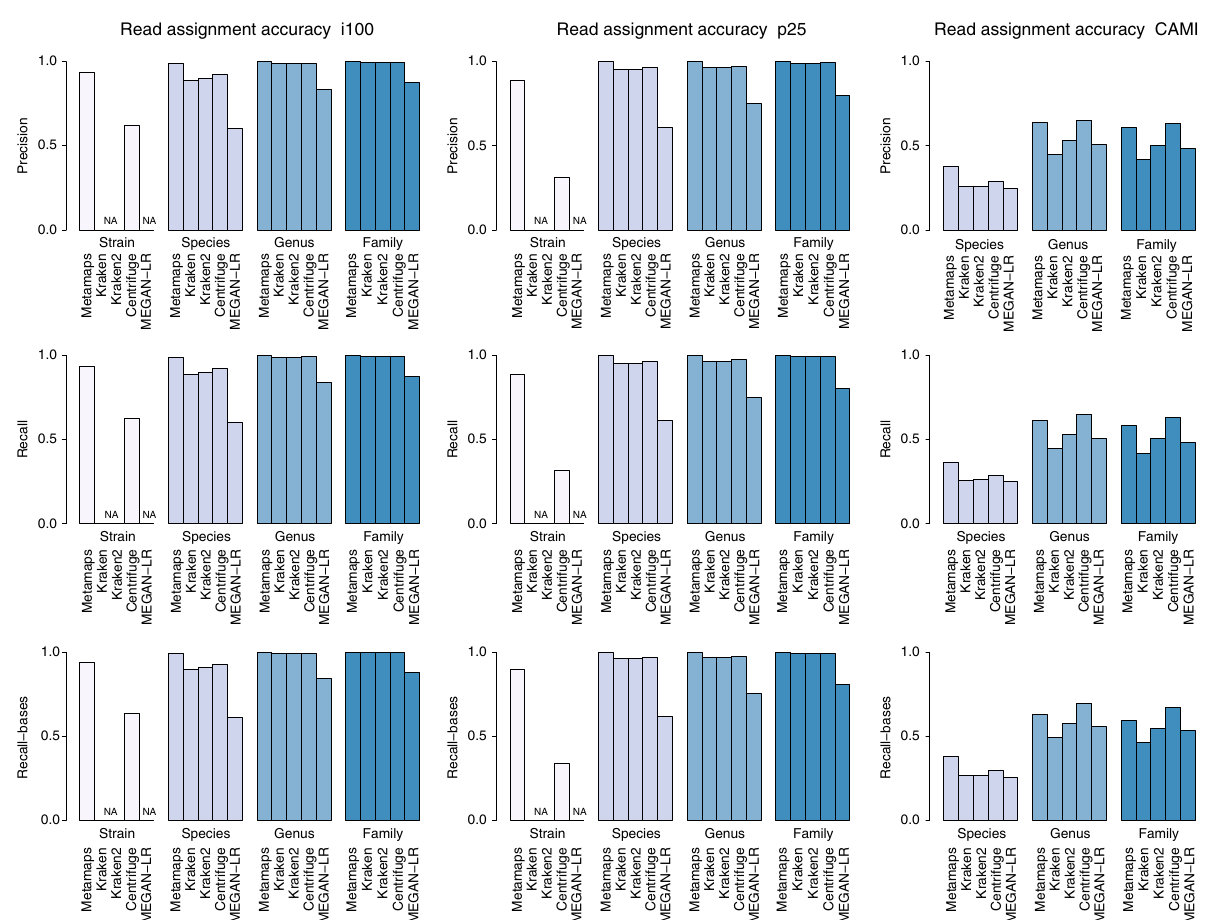
Fig. 1 Read assignment accuracy in experiments with simulated data (i100, p25, and CAMI). Bar plots show precision, recall (read level), and recall (base level) for MetaMaps, Kraken, Kraken 2, Centrifuge and LAST + MEGAN-LR at different evaluation levels. Note that Kraken, Kraken 2 and MEGAN-LR were not designed to achieve strain-level resolution and therefore these tools are not evaluated at this level; also note that the CAMI experiment is not evaluated at the strain level because the CAMI truth set data are not consistently